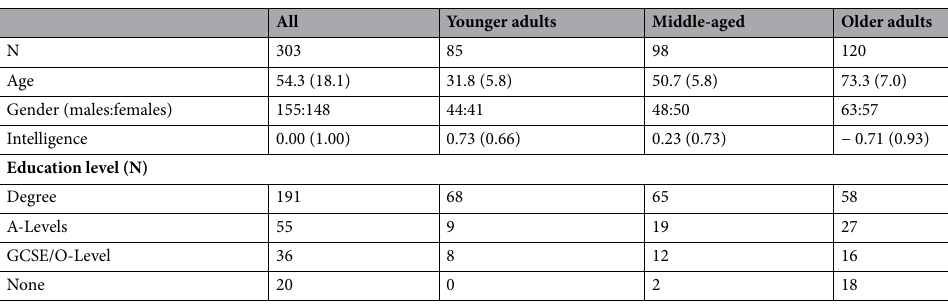
Table 2. Characteristics of participants across ages (18–87 years), younger adults (18–40 years), middle-aged (41–60 years), and older adults (61–87 years). Intelligence refers to the composite score of intelligence on the fluid intelligence test. Information about education level was missing for one participant in the older adults age group. All data are specified as mean (sd) unless otherwise